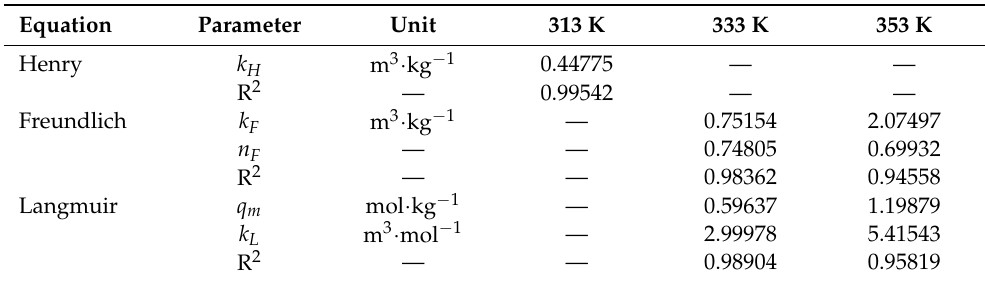
Table 6. Adsorption isotherm parameters for Co(acac) 3 from scCO 2 solution on MCM-41 at 15 MPa and different temperatures [60].